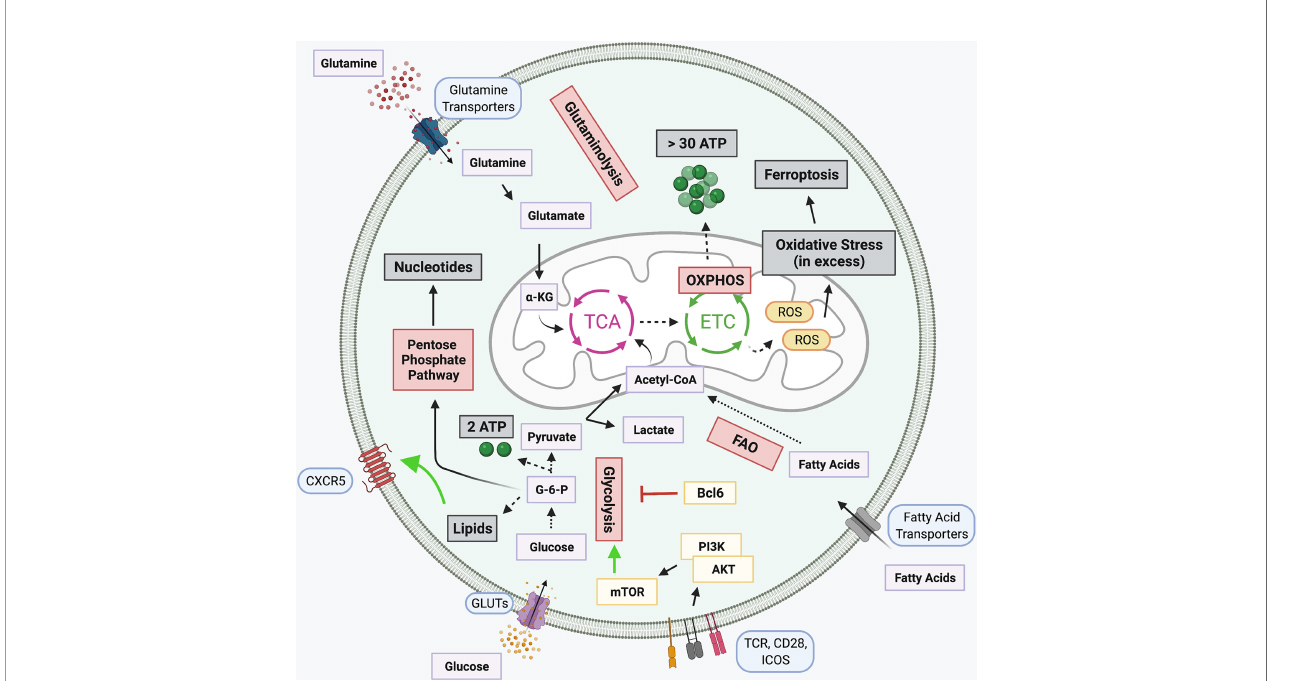
FIGURE 2 | Metabolic pathways in T cells and Tfh-speci fi c alterations. Several signaling networks underly cellular metabolism. Glucose is broken down to produce glycolysis and two ATP molecules in a process known as Glycolysis. Glycolytic intermediates support the pentose phosphate pathway for generation of nucleotides. The pyruvate produced during glycolysis is either converted into lactate or Acetyl-CoA, the latter is subsequently funneled into the tricarboxylic acid (TCA) cycle. Glutaminolysis also fuels the TCA cycle through the breakdown of glutamine into a -ketoglutarate ( a -KG). Products of the TCA cycle, along with the oxidation of fatty acids (FAO), support the electron transport chain (ETC) which is coupled with OXPHOS for the generation of over 30 ATP molecules. When in excess, Reactive oxygen species (ROS) generated by the ETC, induce cellular oxidative stress, promoting apoptotic signaling. Several Tfh signaling pathways either promote or inhibit select metabolic pathways. Lipid metabolism, responsible for the generation of lipids, promotes expression of CXCR5 on the cell surface. Bcl6 can repress the transcription of several glycolytic intermediates, thought to prevent differentiation of alternative T cell subtypes, while TCR, CD28, and ICOS signaling in Tfh potently activate glycolysis through PI3K-linked activation of mTOR signaling. Created with